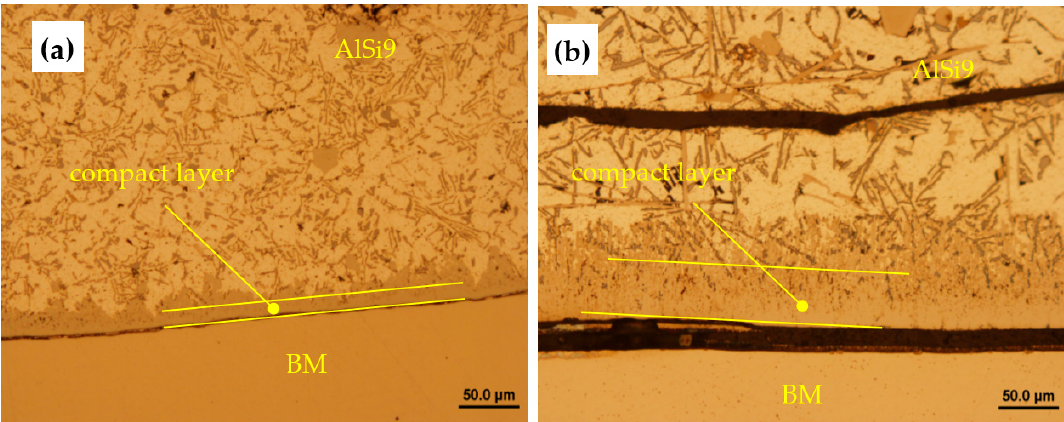
Figure 23. Intermetallic compounds at boundary between BM and solidified aluminum alloy melt after